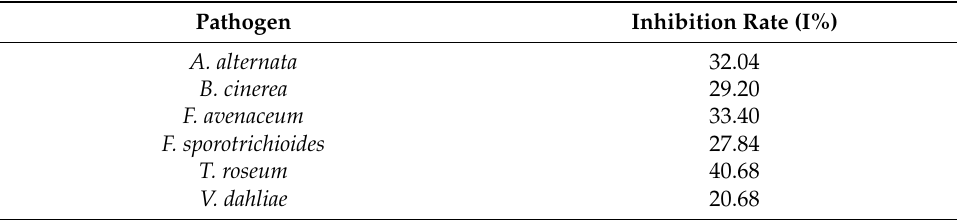
Table 2. Mycelial growth inhibition percentage (I%) after 16 days of